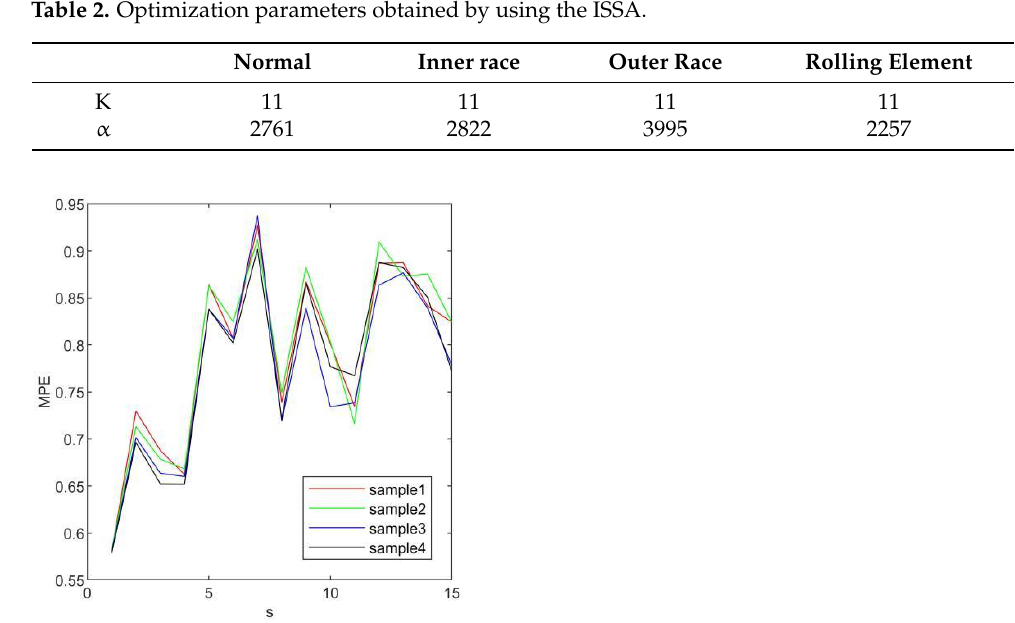
Table 2. Optimization parameters obtained by using the ISSA.